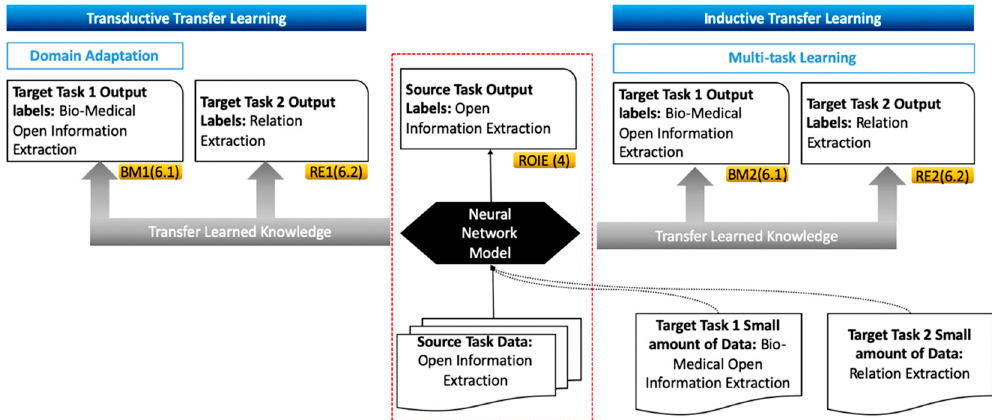
Figure 1. Open information extraction (OIE) transfer learning assessment. A total of four transfer learning experiments were carried out in our work. Left: the two transductive transfer learning experiments (BM1 and RE1). Right: illustration of the two experiments using inductive approaches (BM2 and RE2). Middle: the red dotted line represents the original model (ROIE), in which we tested our proposed neural model by testing and training on OIE news data, which is discussed in Section 4. The experiments’ ID and the section they are discussed in are encapsulated in the yellow rectangles.